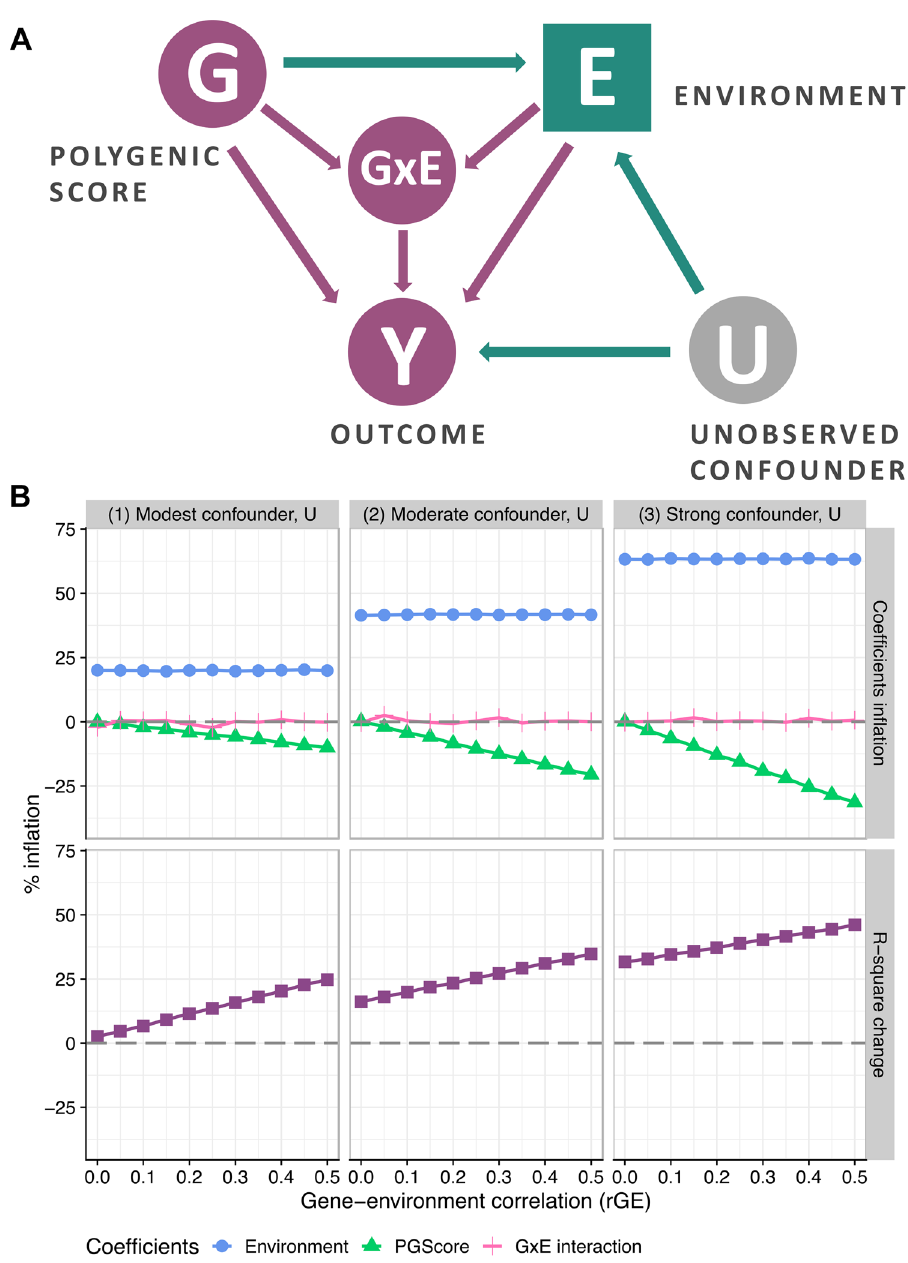
Figure 2. Collider bias in polygenic gene-environment interaction models. Panel A. Schematic diagram of the collider bias which occurs between polygenic score, environment, and outcome in cases of gene-environment interdependence. Dark purple circles represent variables, unobserved confounders are shown in grey circles, collider variables are indicated in squares. By adding E into the model with the polygenic score G, we make E a collider. A collider that is not conditioned on, blocks the path between its sources (G and U); once a collider is controlled for, the path is opened as indicated by green nodes. Panel B (top). Spurious regression estimates for the polygenic score and environment along with non-inflated interaction terms from the series of OLS simulations reflecting a range of gene-environment interdependence and the presence of modest, moderate, or strong confounder, U. Collider bias due to positive values of gene-environment correlation and the presence of an uncontrolled confounder, which is positively correlated with covariate and outcome, results in deflation of polygenic score estimates. Deflation is greater the higher the gene-environment correlation; greater confounding also results in greater bias. The interaction term is not affected but results for moderation analysis are biased as long as direct effects are spurious. Panel B (bottom). R-squared inflation plot from the series of OLS simulations; collider bias results in inflated values of explained variance statistics. R-squared statistics for the model with endogenous covariate and polygenic score includes not only the true share of the variance in Y explained by G and E (baseline estimate indicated by 0), but also the elements of variance that are due to gene-environment correlation and confounder(s),